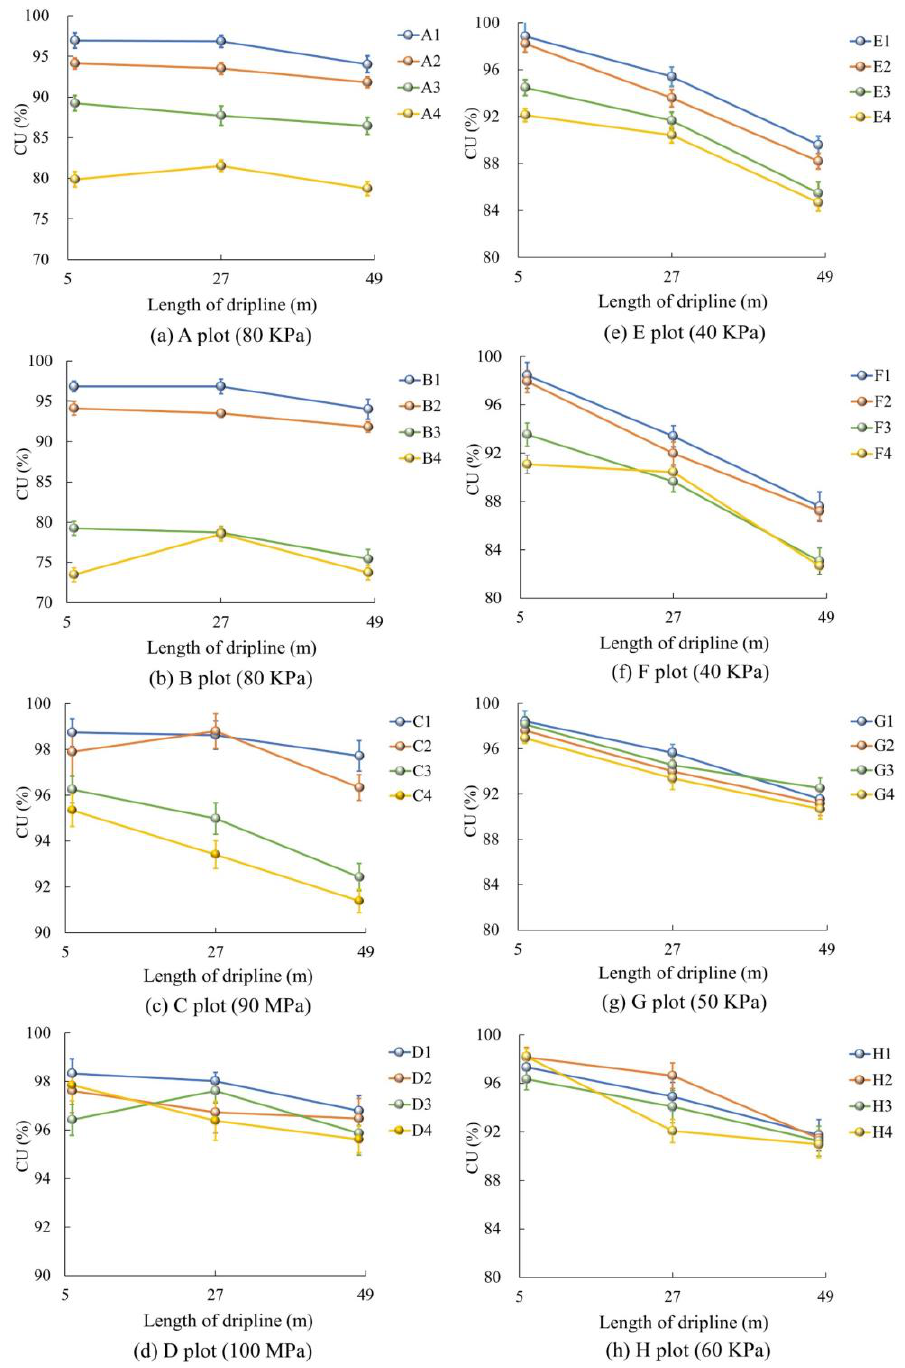
Figure 2. Christiansen uniformity coefficient at different lengths of driplines. Note: CU is the Christiansen uniformity coefficient; the values are the means ± standard error. A, B, C, D, E, F, G, H represent different experimental plots. The 1, 2, 3, and 4 after the same letter represent the working conditions of the same type of driplines matched with different filters at the same pressure, respectively. The 1, 2, 3, and 4 represent the working conditions with the disc filter with aperture of 125 μm, the screen filter with aperture of 125 μm, the screen filter with aperture of 200 μm and no filter, respectively.